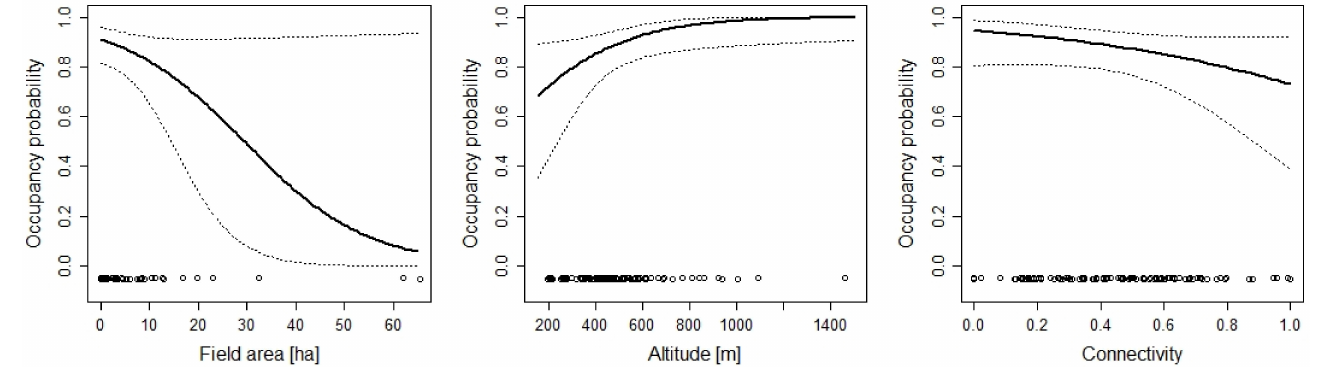
Figure 6. The effect of the area of fields, altitude, and connectivity on the occupancy probability of Ichthyosaura alpestris . For additional explanations, see the caption of Figure